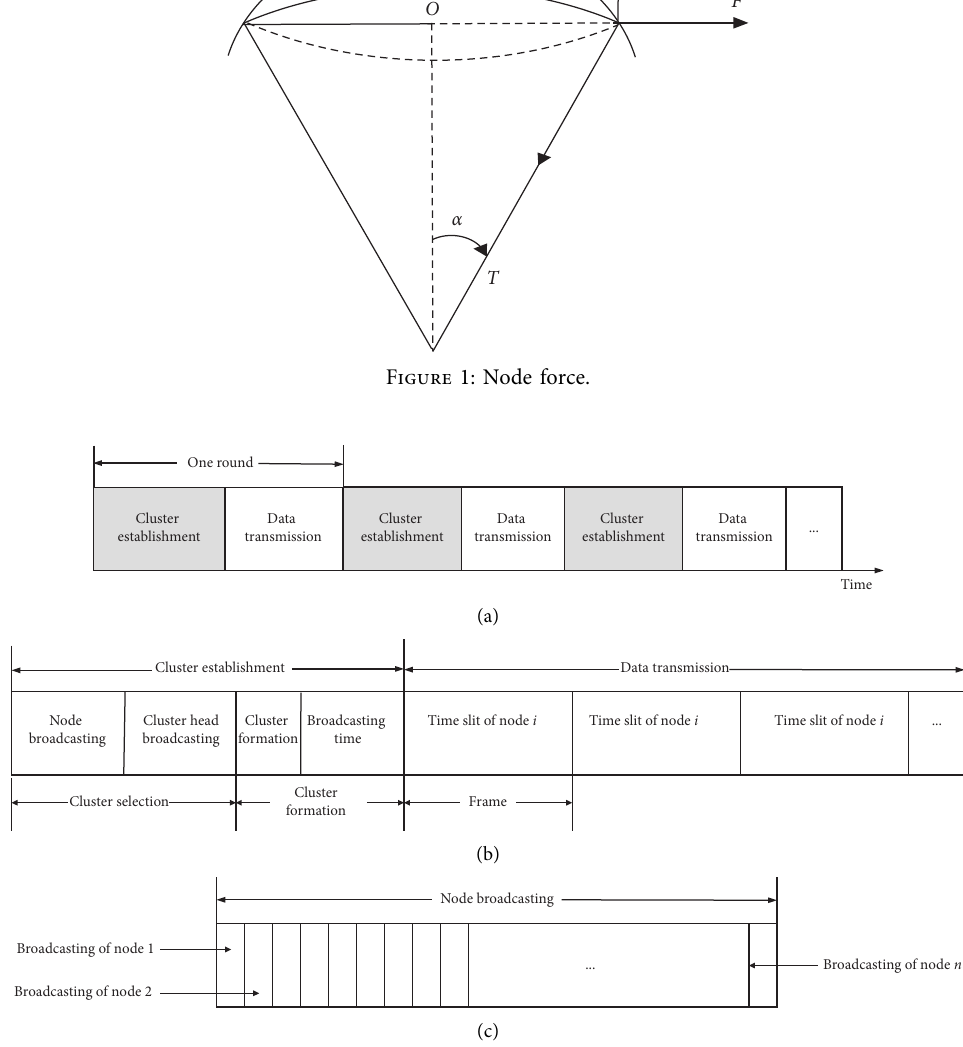
Figure 2: Schedule architecture of DHCDGA.